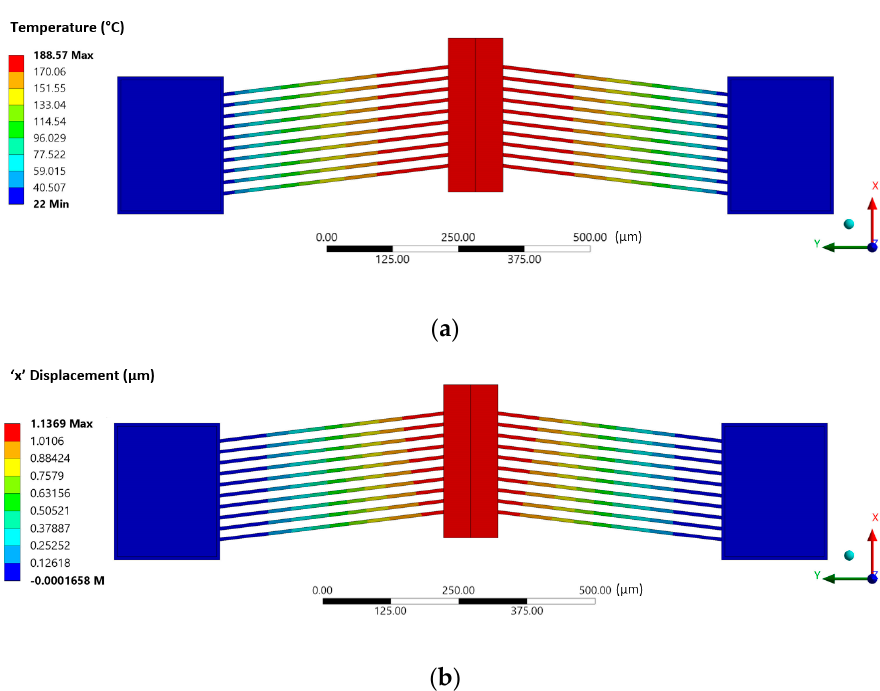
Figure 10. Sequential coupling numerical results of ( a ) temperature distribution and the ( b ) corre- sponding displacement in the steady-state operation under an applied potential of 10 V DC.